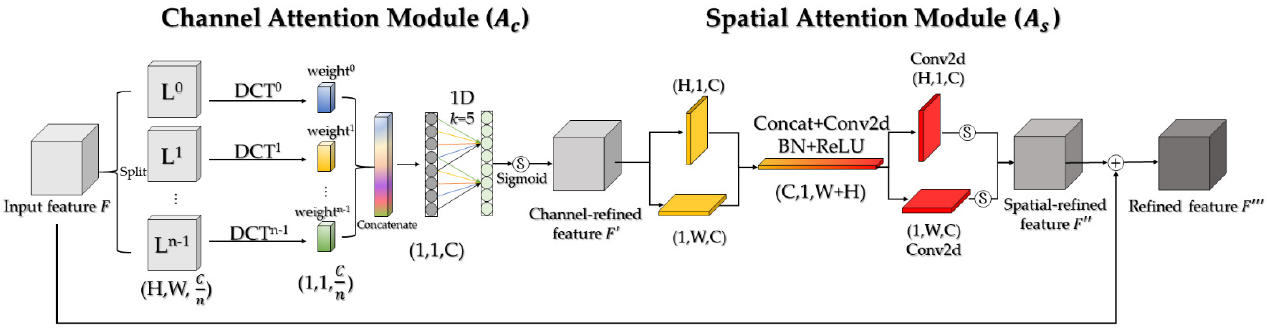
Figure 10. The overall structure of LRCA-Netv3 using the improved channel attention module.